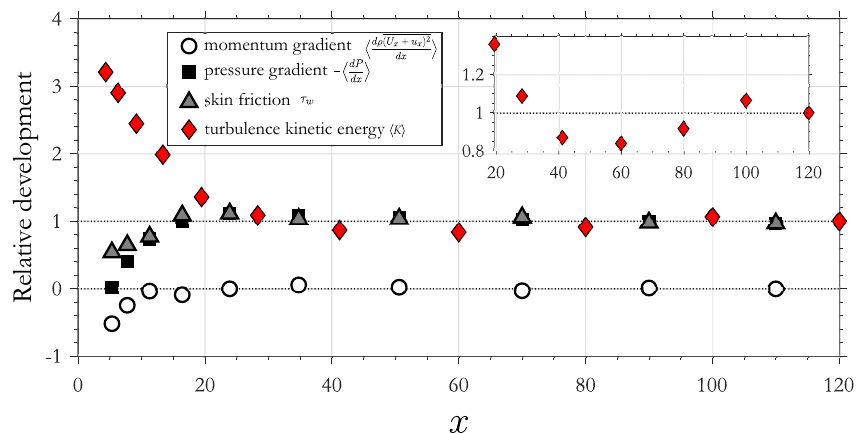
Figure 1. Stream-wise relative development of the pressure gradient, skin friction, stream-wise momentum gradient, and the cross-sectional area average of the turbulence kinetic energy. Here, x = x s / R , where x s is measured from the start of the smooth pipe. (Reproduced with permission from [37], published by Cambridge University Press